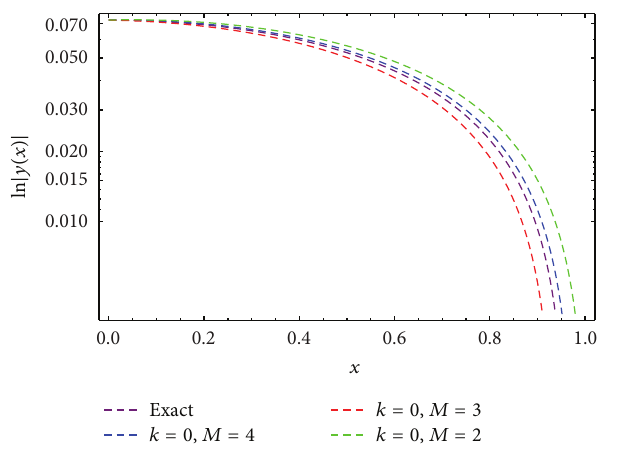
Figure 1: Different solutions of Example 2. Figure 2: Different solutions of Example